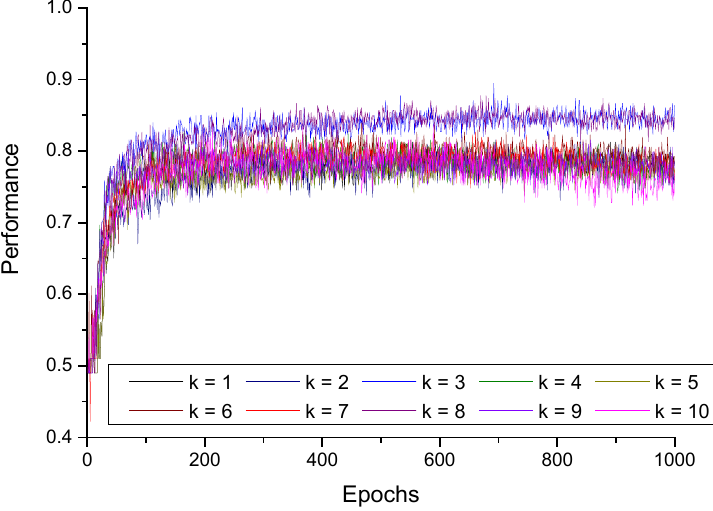
Figure 9. Learning curves for 10 performances using the fully connected DNN.